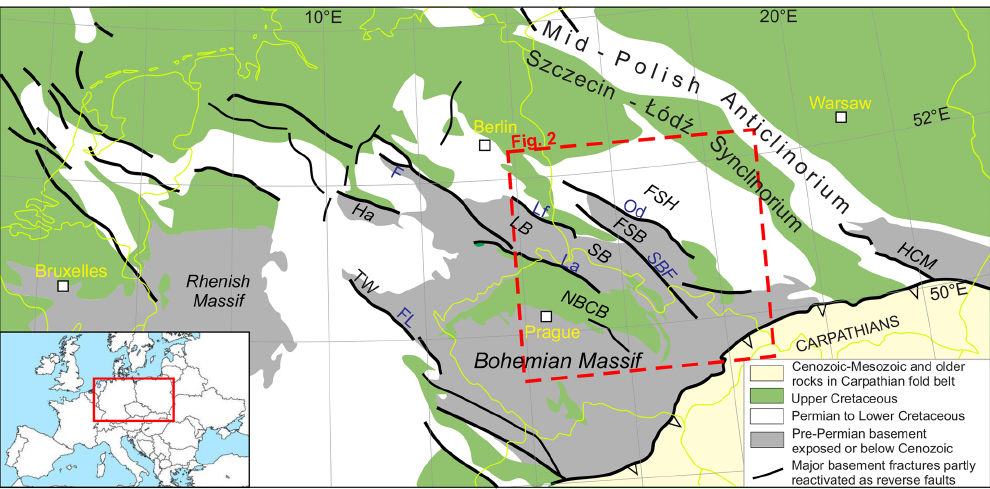
Figure 1. The main Late Cretaceous–early Palaeogene tectonic structures in central Europe. Modified after Kley and Voigt (2008).